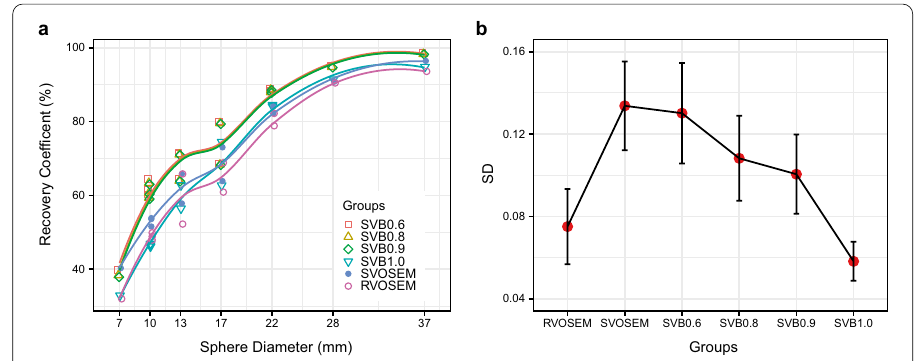
Fig. 1 Recovery coefficients (RC) and the standard deviation (SD) of the CTN phantom. a The RCs were plotted against the diameter of the spheres. The trend lines were fitted with local polynomial regression model for each group. The hot spheres in the phantom background had higher RCs than those in the polystyrene‑filled chambers with the same diameter. The difference of the RC is most obvious at the diameters of 10, 13, 17, and 22 mm. The trend lines pass through in the middle of the two data points of the RCs. b The mean of the SD was calculated by averaging the SDs from eight VOIs placed in the phantom background and plotted for each reconstruction group (red dot). The error bar showed the standard deviation of the SD that was also calculated from eight VOIs placed in the phantom background. A narrower error bar represents that the image noise was more homogeneous across different regions in the phantom